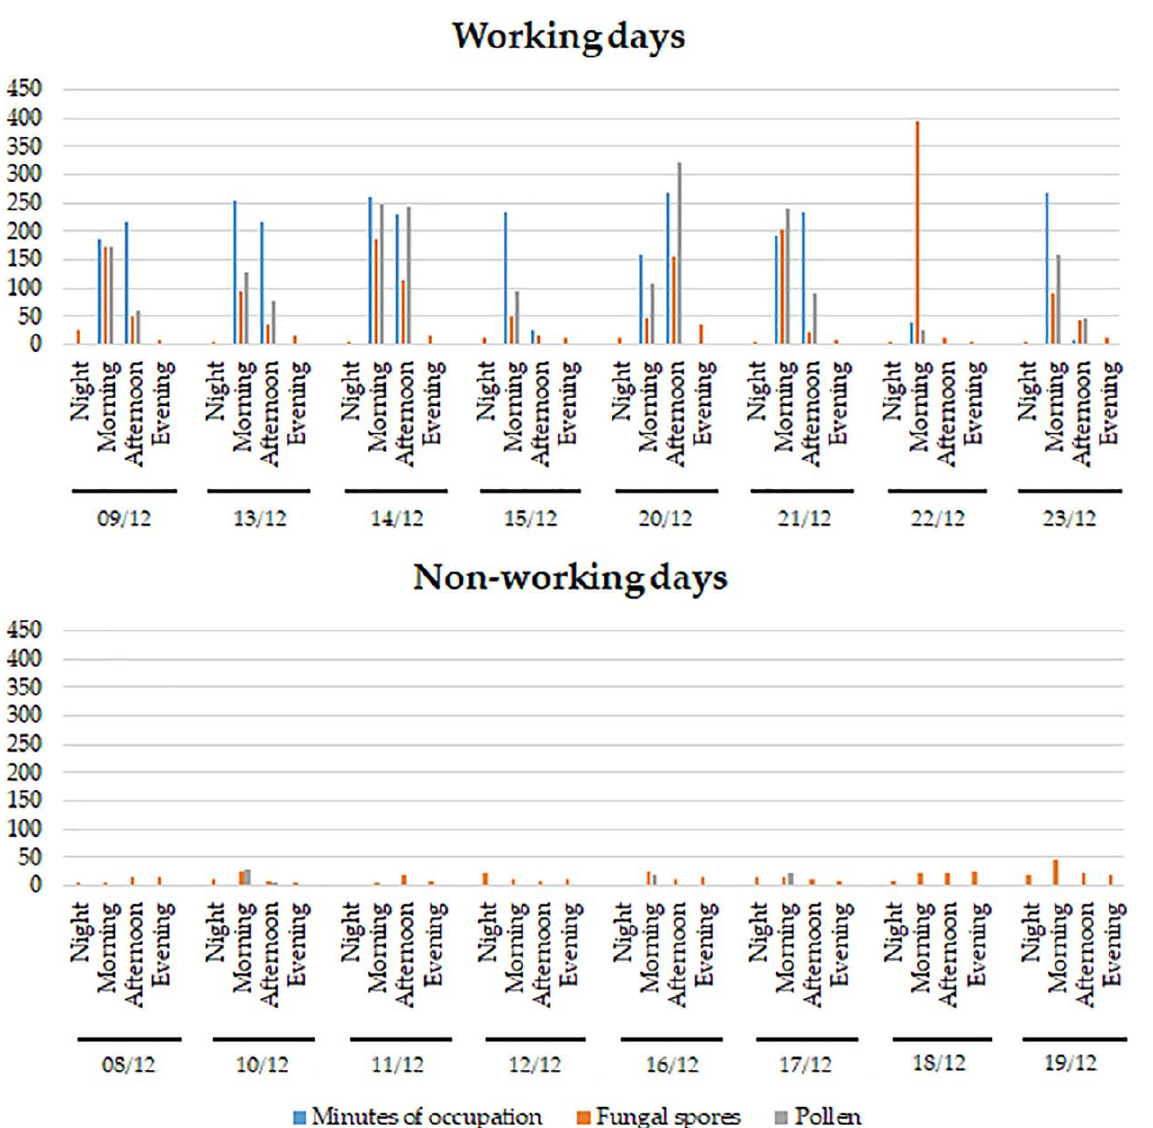
Figure 8. Number of minutes of room occupation and number of pollen and fungal spore related particles (y-axis) for each day and each part of the day (x-axis). Working (WDs) and non-working days (NWDs) are shown separately. Table 4. WHs and NWHs (evening + night vs. morning + afternoon) inside WDs; WDs vs. NWDs. (Mann-Whitney Rank Sum